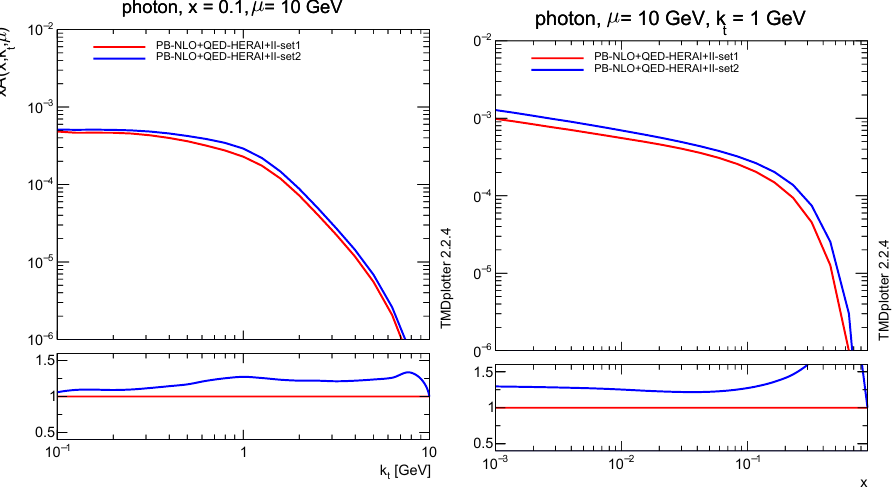
Figure 3: Comparison of photon TMDs for Set 1 and Set 2 plotted against k and x